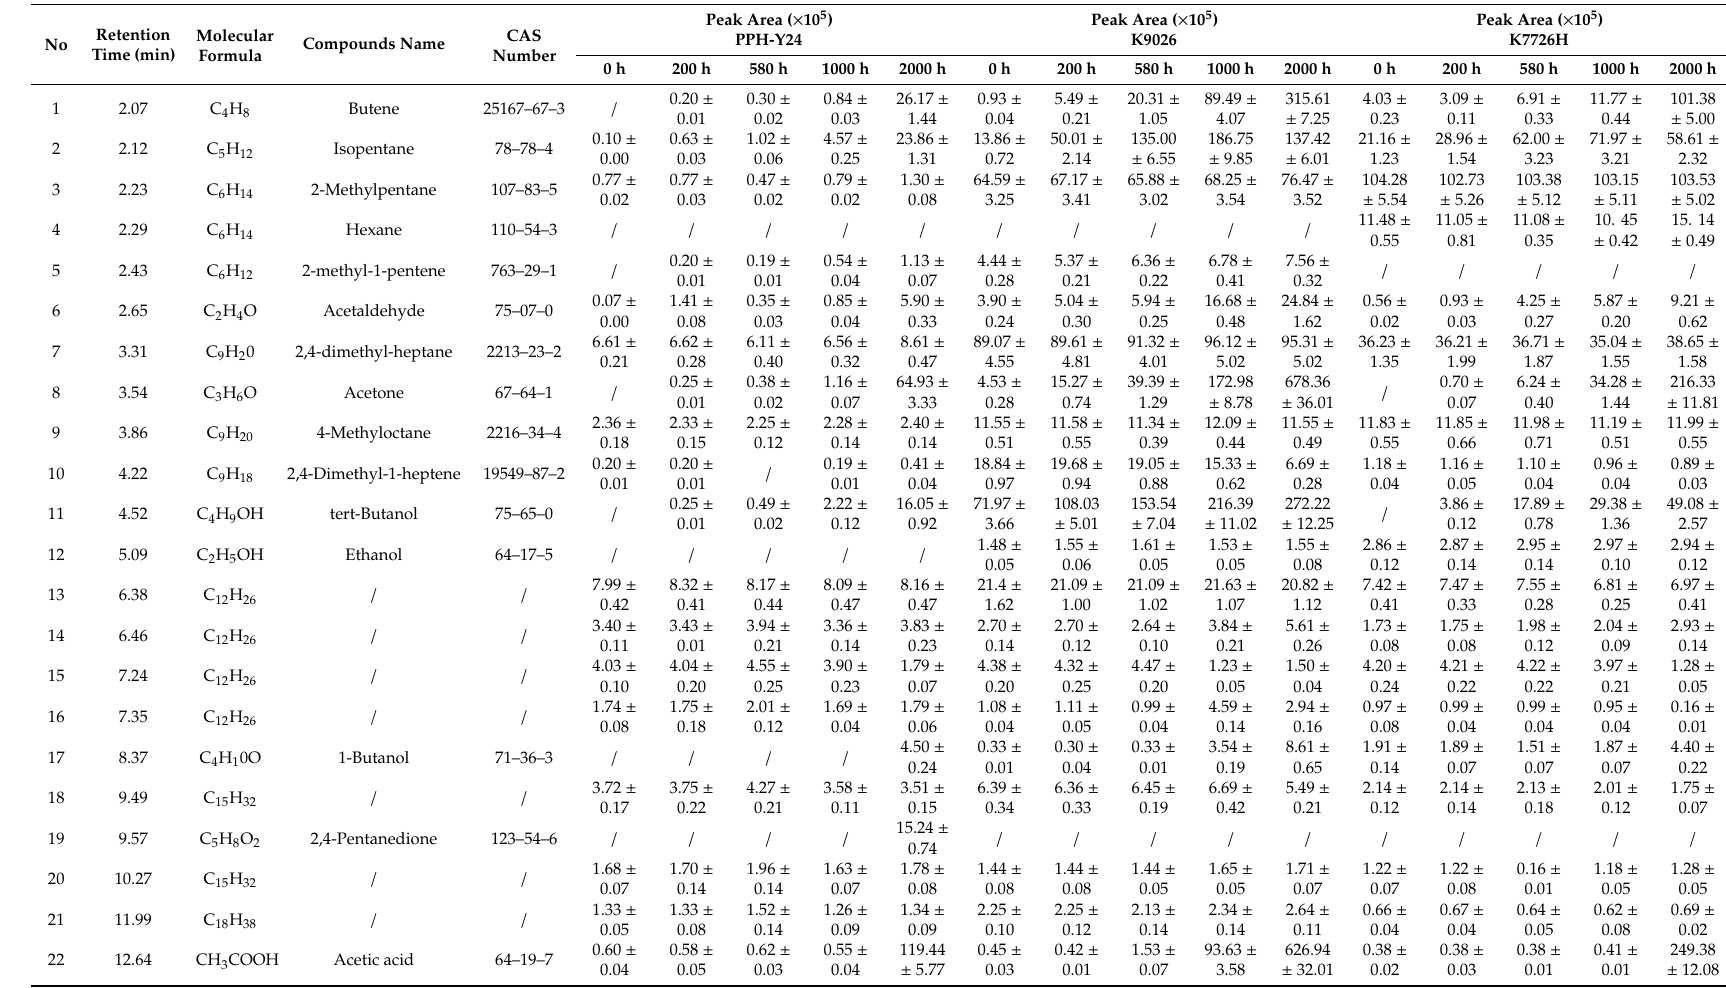
Table 1. Changes of VOCs of neat polypropylene (PP) resins during the accelerated photoaging monitored by Headspace extraction-Gas Chromatography / Mass Spectroscopy (HS-GC /